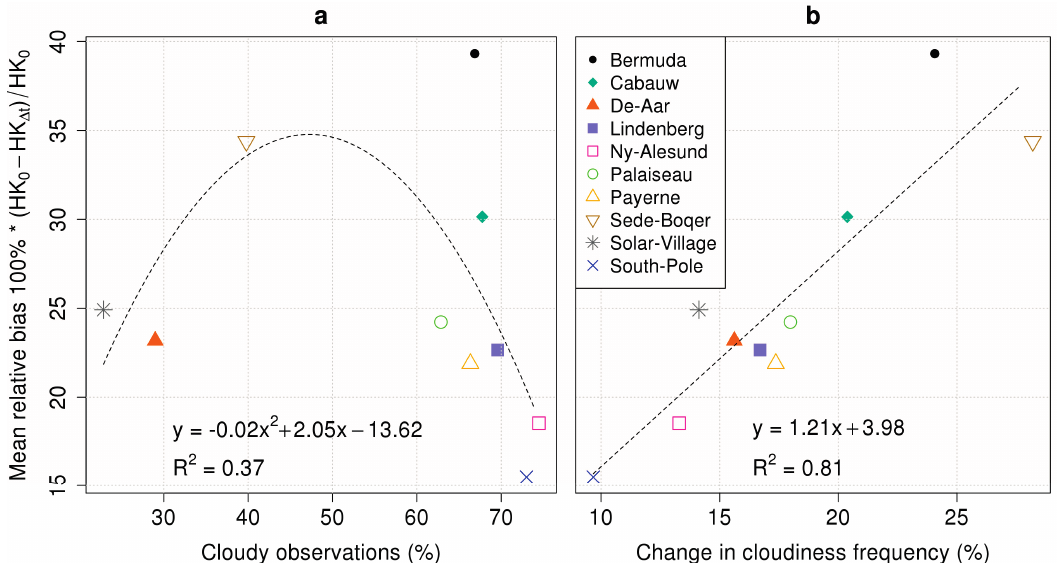
Figure 6. The mean relative bias of the Hanssen-Kuiper’s discriminant derived for all time differences Δ t from 10 to 90 min in relation to ( a ) the mean cloudiness and ( b ) the percent of changes in cloudiness (cloudy-cloudless) in the total number of observations at each BSRN site. Additionally the least square regression and its coefficient of determination (R 2 ) are